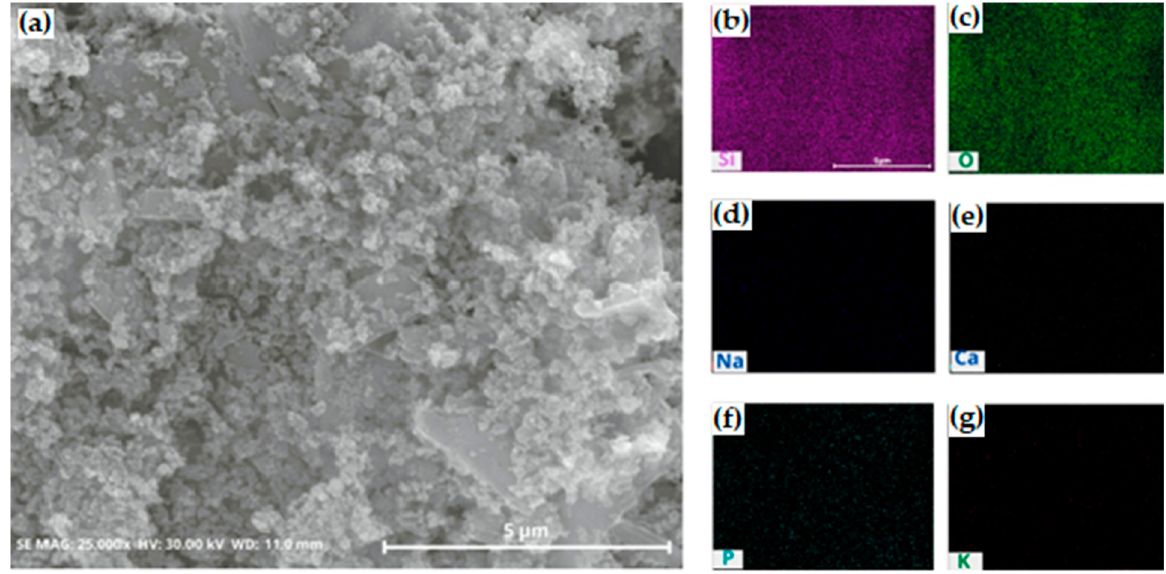
Figure 11. ( a ) SEM and ( b – g ) EDS mapping images of silica after cleaning with deionized water. The purified silica was cleaned at 60 °C, 300 rpm, for 3 h. ( b ) silicon; ( c ) oxygen; ( d ) sodium; ( e ) calcium; purified silica was cleaned at 60 ◦ C, 300 rpm, for 3 h. ( b ) silicon; ( c ) oxygen; ( d ) sodium; ( e ) calcium; ( f ) phosphor; ( g ) potassium. ( f ) phosphor; ( g )